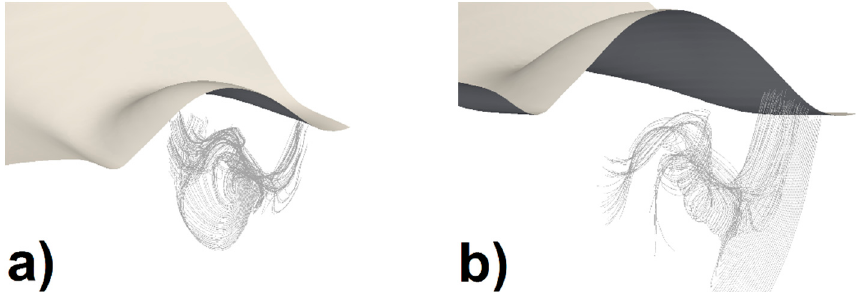
Figure 4. Simulated flow streamlines in a region where vortices are experimentally observed (case A, w = 1.0 m/s, τ = 18 ms).